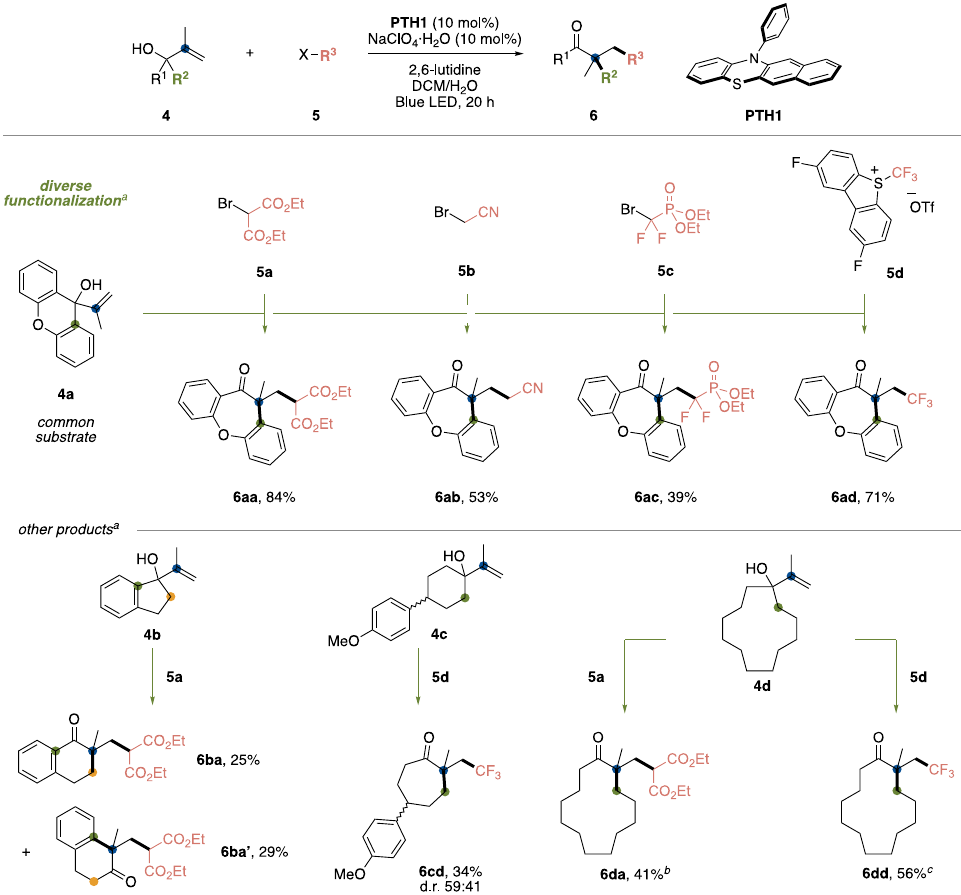
Fig. 3 Substrate scope of alkylative semipinacol type rearrangement. a Reaction was carried out with 4 (0.2 mmol), 5 (0.3 mmol), PTH1 (0.02